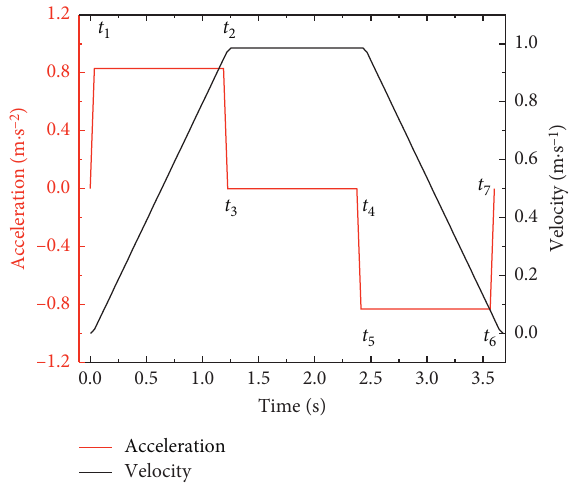
Figure 4: Lifting speed and acceleration curve. Table 1: Parameters of the experiment device.